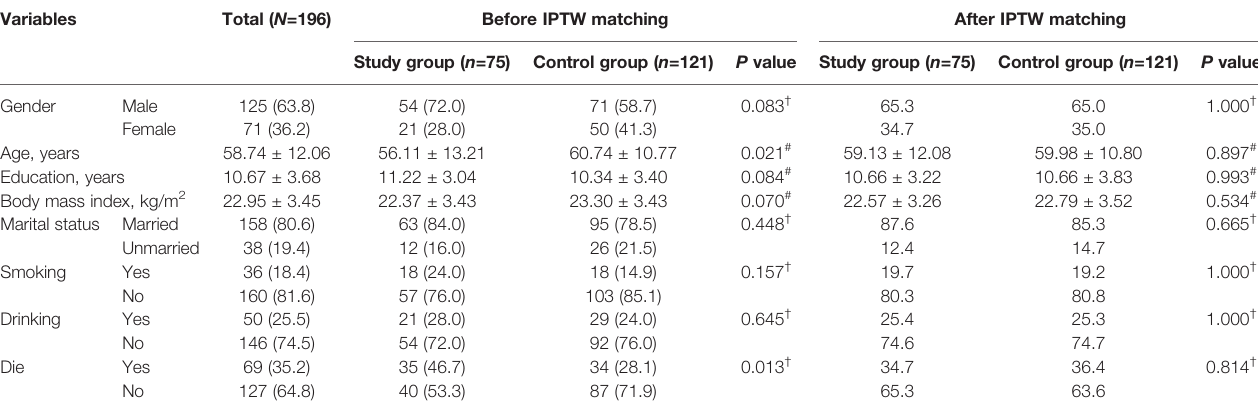
TABLE 1 | Study characteristics before and after IPTW * . Variables Total ( N